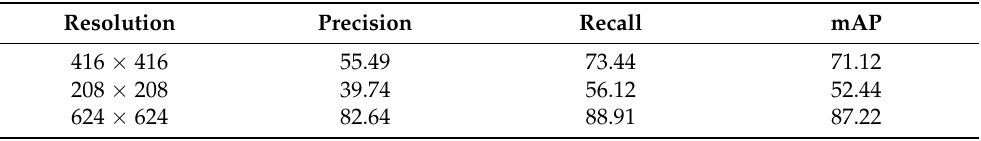
Table 11. Results of varying image resolutions from